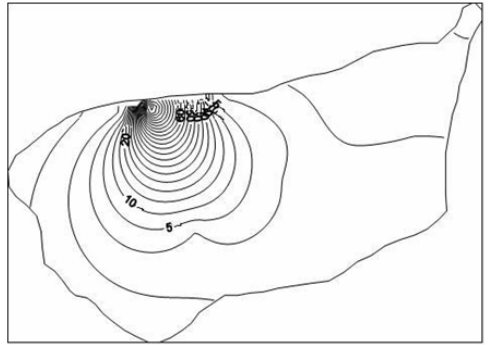
Figure 10. Seasonal variations of NO